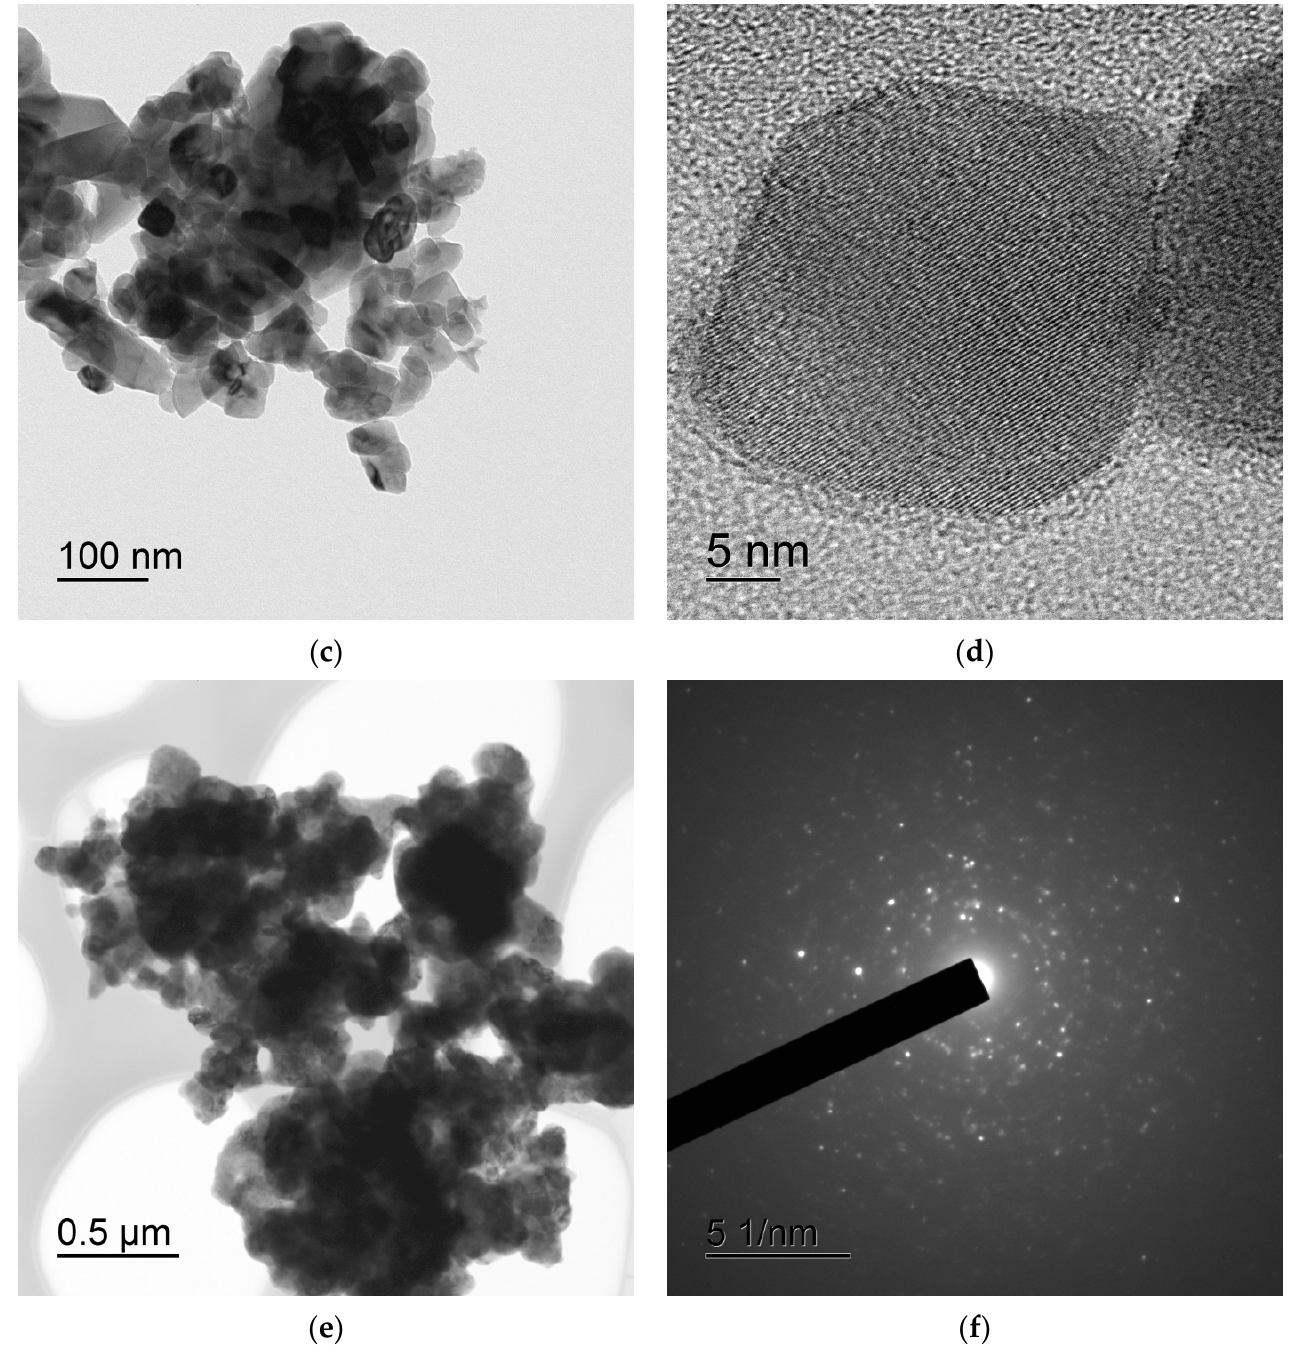
Figure 4. TEM images of the powders Ca 1-x Zr 2 (PO 4 ) 3-x (MoO 4 ) x with x = 0.1 ( a , b ), x = 0.3 ( c , d ), x = 0.4 ( e , f ).